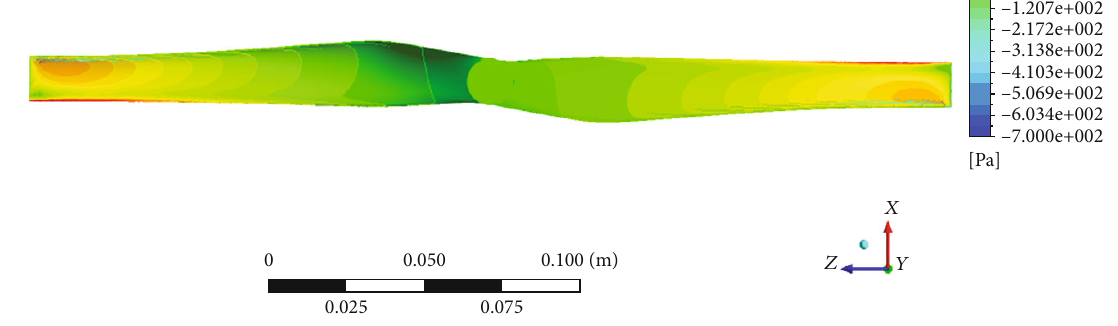
Figure 19: Pressure side of the blade.